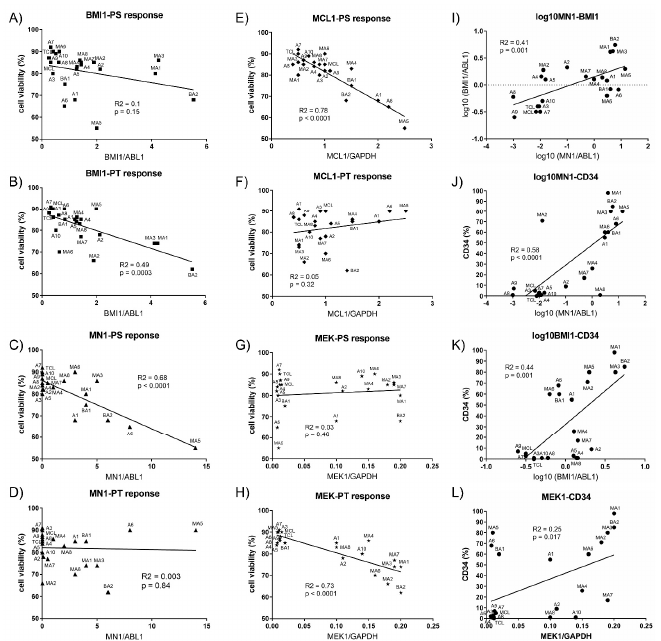
Figure 7. Biomarkers of response to PTC596 combination treatments. AML cell responses to combination treatments PTC596 and S63845 ( A , C , E , G ) or PTC596 and trametinib ( B , D , F , H ) were correlated to BMI1 gene expression ( A , B ), MN1 gene expression ( C , D ), MCL1 protein levels ( E , F ), and MEK1 protein levels ( G , H ). Positive association of MN1 and BMI1 gene expression ( I ). Positive association of MN1 gene expression ( J ), BMI1 gene expression ( K ), and MEK1 protein levels ( L ) with CD34 positivity of leukemic cells.